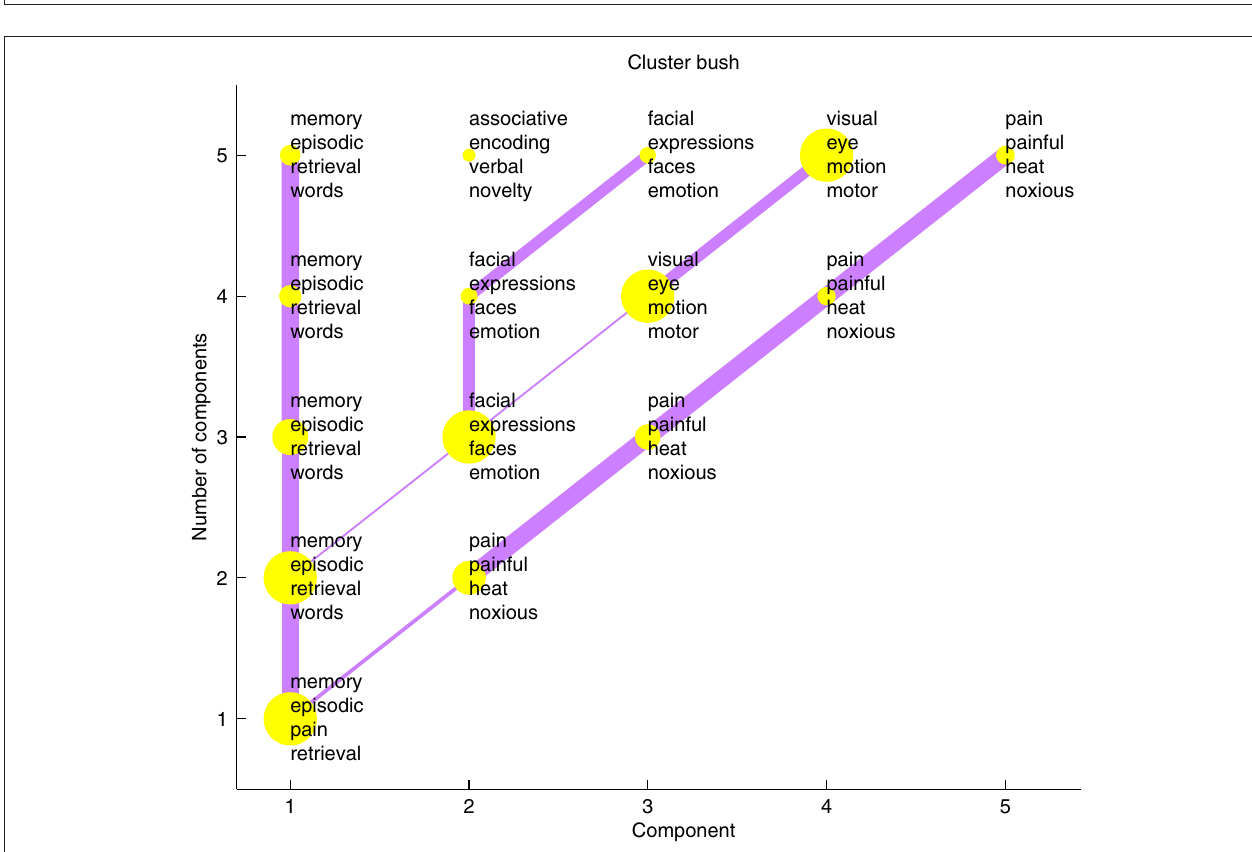
FIGURE 8 | Screenshot of a VRML rendering seeking to convey parts of the information surrounding a neuroimaging study: 3D icons for funding, research organization, researchers, software, subjects, and scanner placed in a torus.